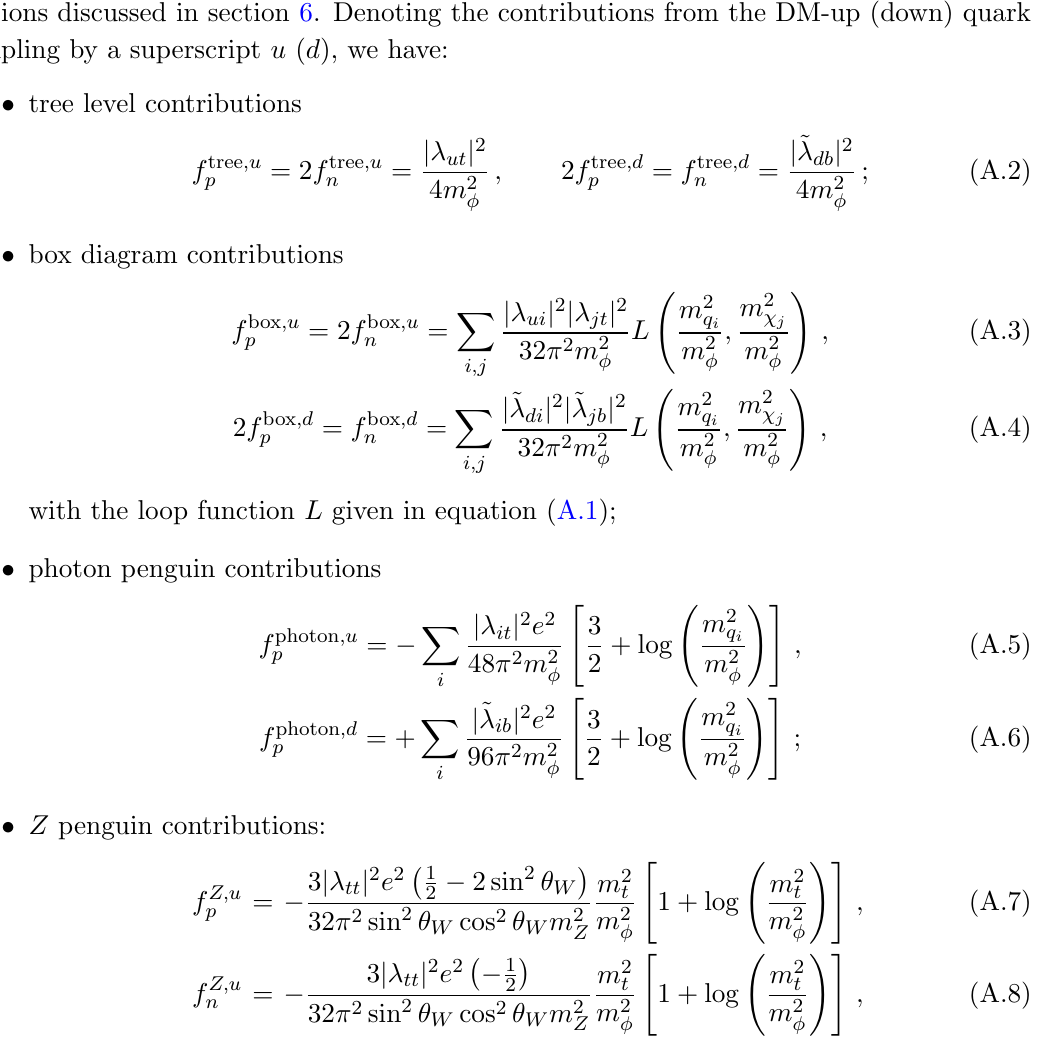
, and neutrons, f , receive various contri- p n